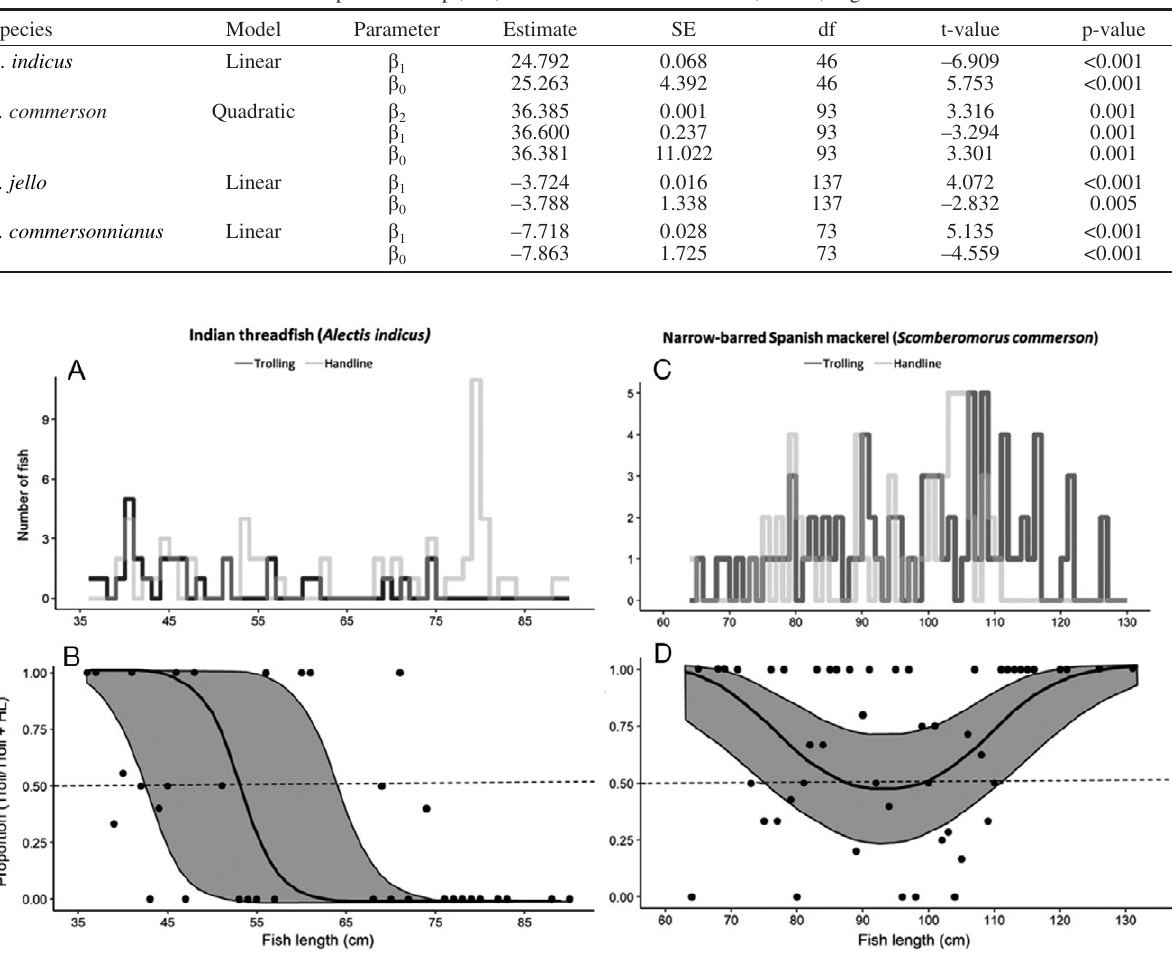
), linear ( β ), quadratic ( β ), or cubic ( β )]. Estimate is 0 1 2 3